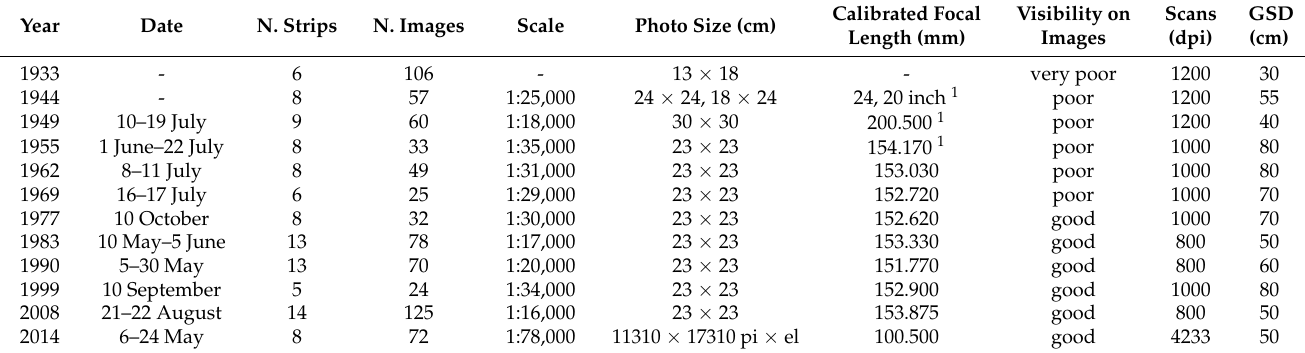
Table 1. Characteristics of the aerial photogrammetric surveys used in this study (GSD: ground sample